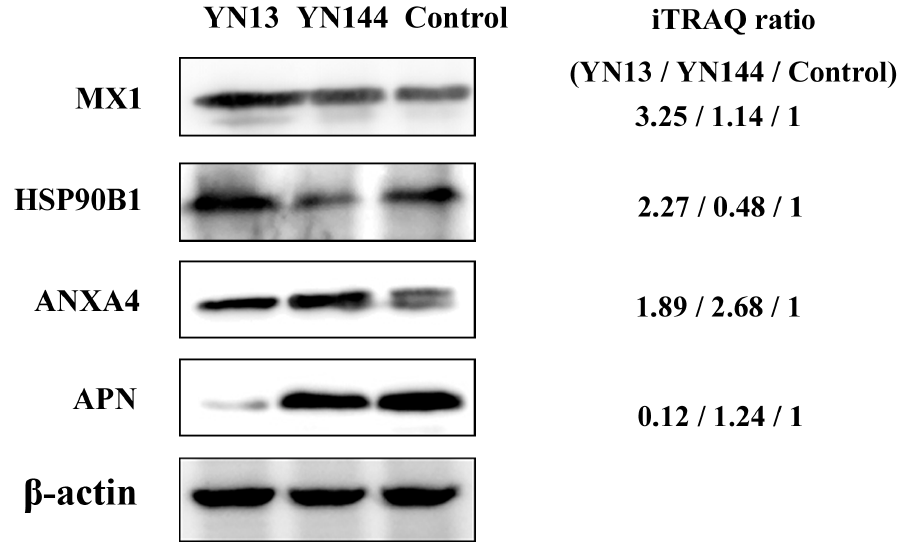
Figure 5. Confirmation of differentially expressed proteins by Western blot. Analysis of MX1, heat shock protein 90 kDa beta member 1 (HSP90B1), Annexin A4 (ANXA4), and Aminopeptidase N (APN) expression level in YN13-infected, YN144-infected, and the control groups. iTRAQ ratios (YN13/YN144/Control) are shown on the right.